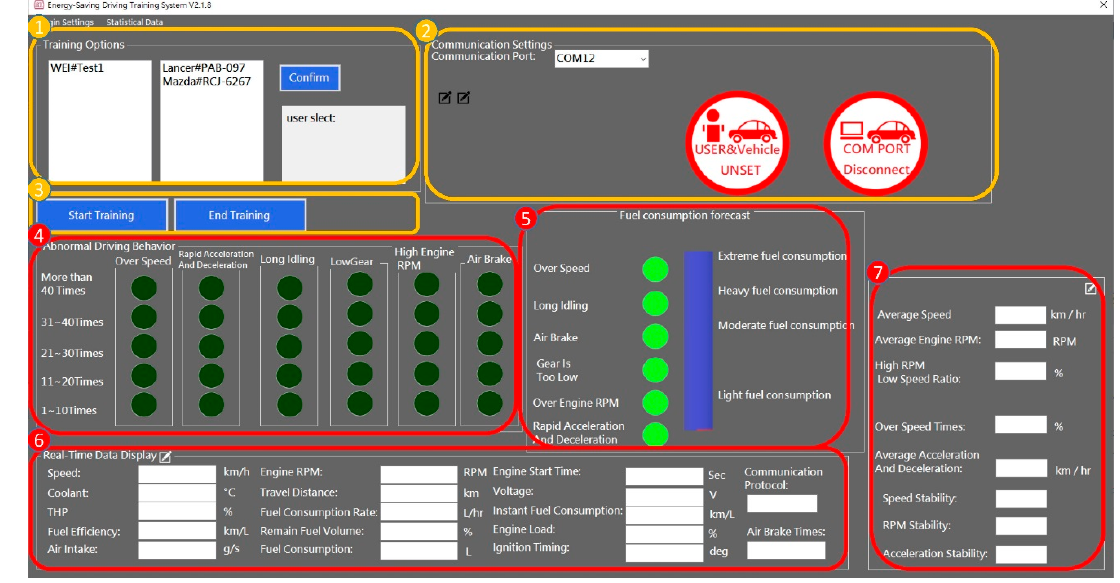
Figure 6. Developed GUI of the eco-driving assistant